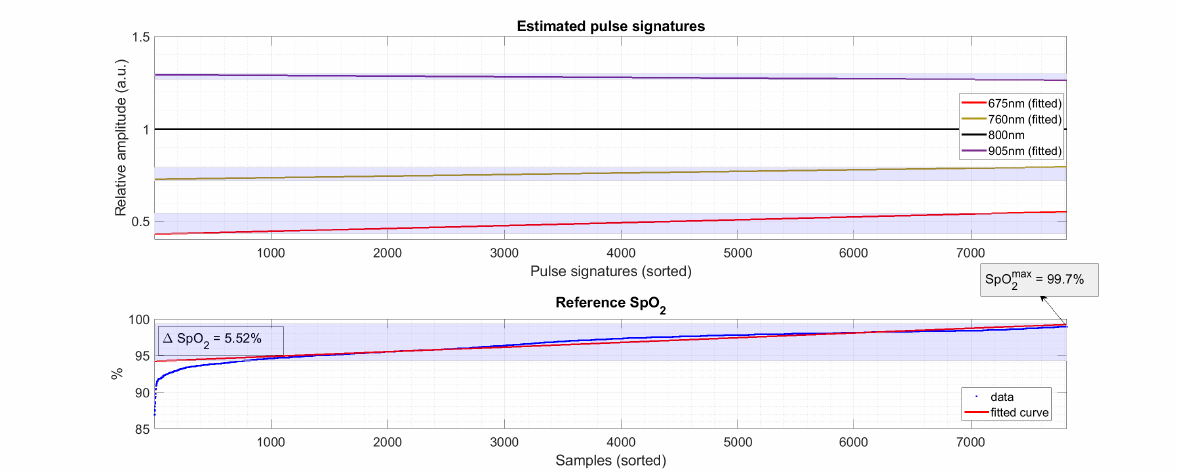
Figure 5. The APBV calibration model is derived from P s ∗ The update vector P u calculated by linear regression using SpO max